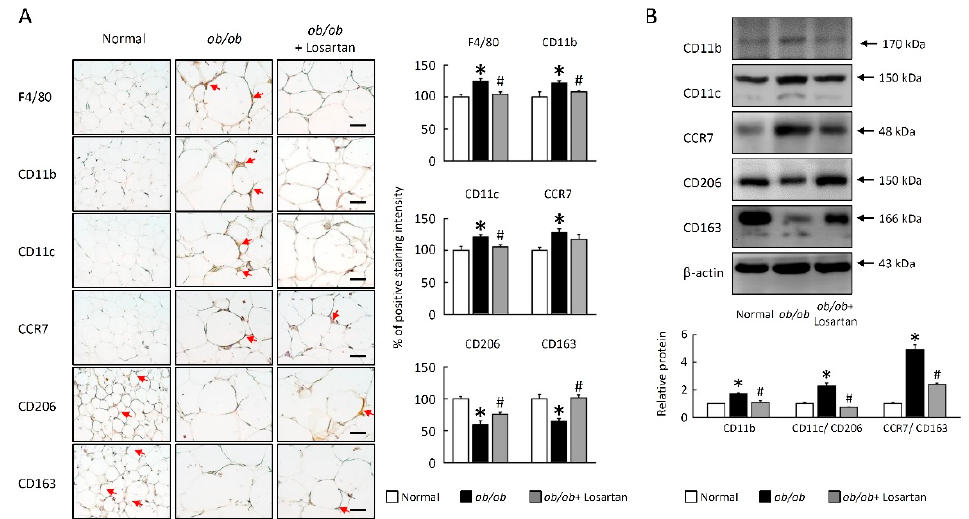
Figure 5. Losartan regulated macrophage polarization in EWAT. ( A ) Representative F4/80, CD11b, CD11c, CCR7, CD206, and CD163 staining of EWAT. Red arrow highlights the positive staining. Scale bar: 100 µ m. Tissue staining, as quantified by either stain intensity, is represented on the left-hand vertical axis in each graph. ( B ) Quantification of CD11b, CD11c, CCR7, CD206, CD163, and β -actin protein levels by Western blot. Ratio of CD11c/CD206 and CCR7/CD163 in the EWAT. For each animal group, n = 5. All values represent the mean ± SEM. Data were analyzed by Student’s t test. * p ≤ 0.05; normal vs. ob/ob . # p ≤ 0.05; ob/ob vs. ob/ob + Losartan. EWAT: epididymal white adipose tissue.